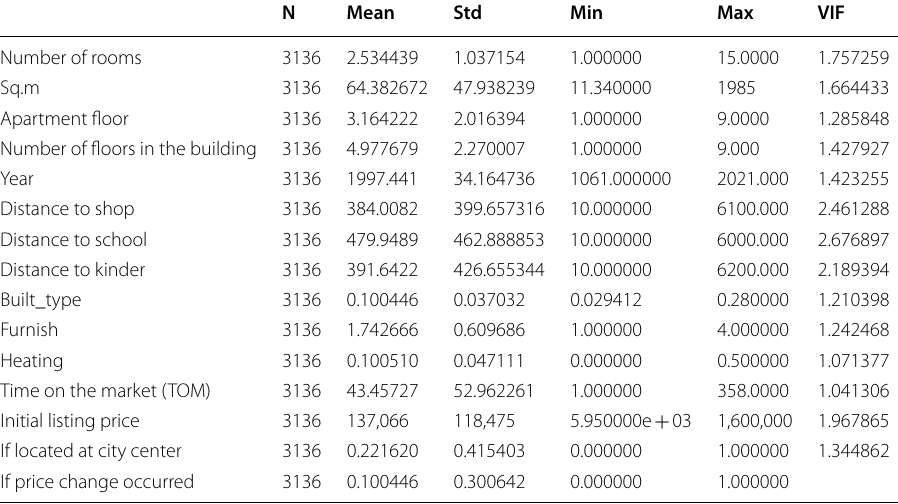
Table 6 Sample descriptive statistics for month July sell operations